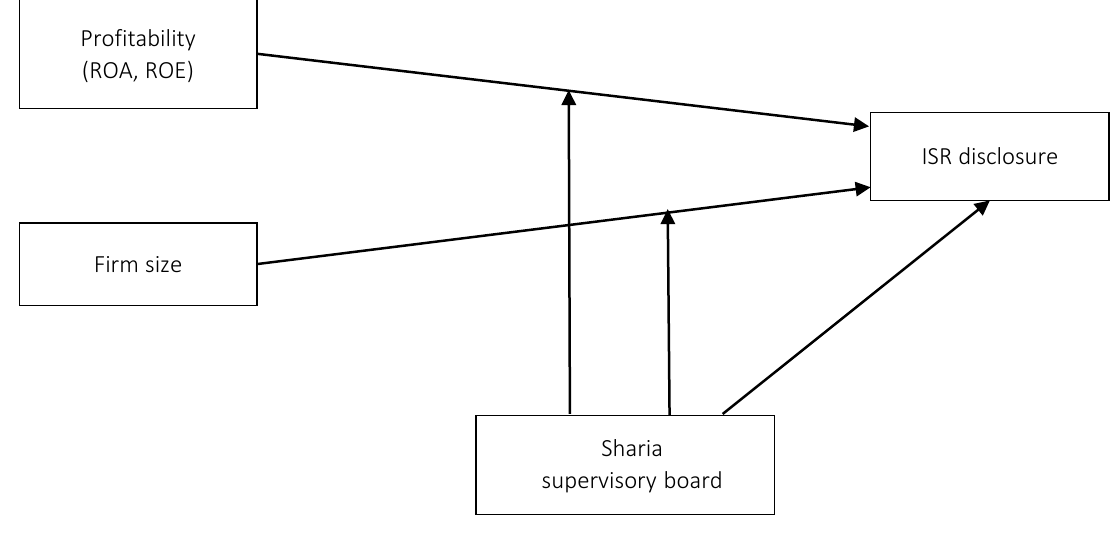
Figure 1. Conceptual framework